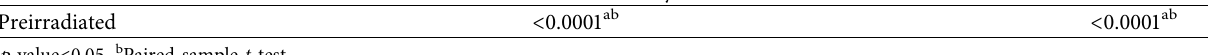
Mean 2733.5 ± 589.9 Table 5: Comparison of bFGF levels in amnion sponge before and after radiation sterilization. Postirradiated 15kGy Postirradiated 25kGy Preirradiated < 0.0001 ab < 0.0001 ab a p value < 0.05. b Paired-sample t -test. Table 6: bFGF levels in the freeze-dried amnion membrane (FD-AM) and amnion sponge before and after radiation sterilization.